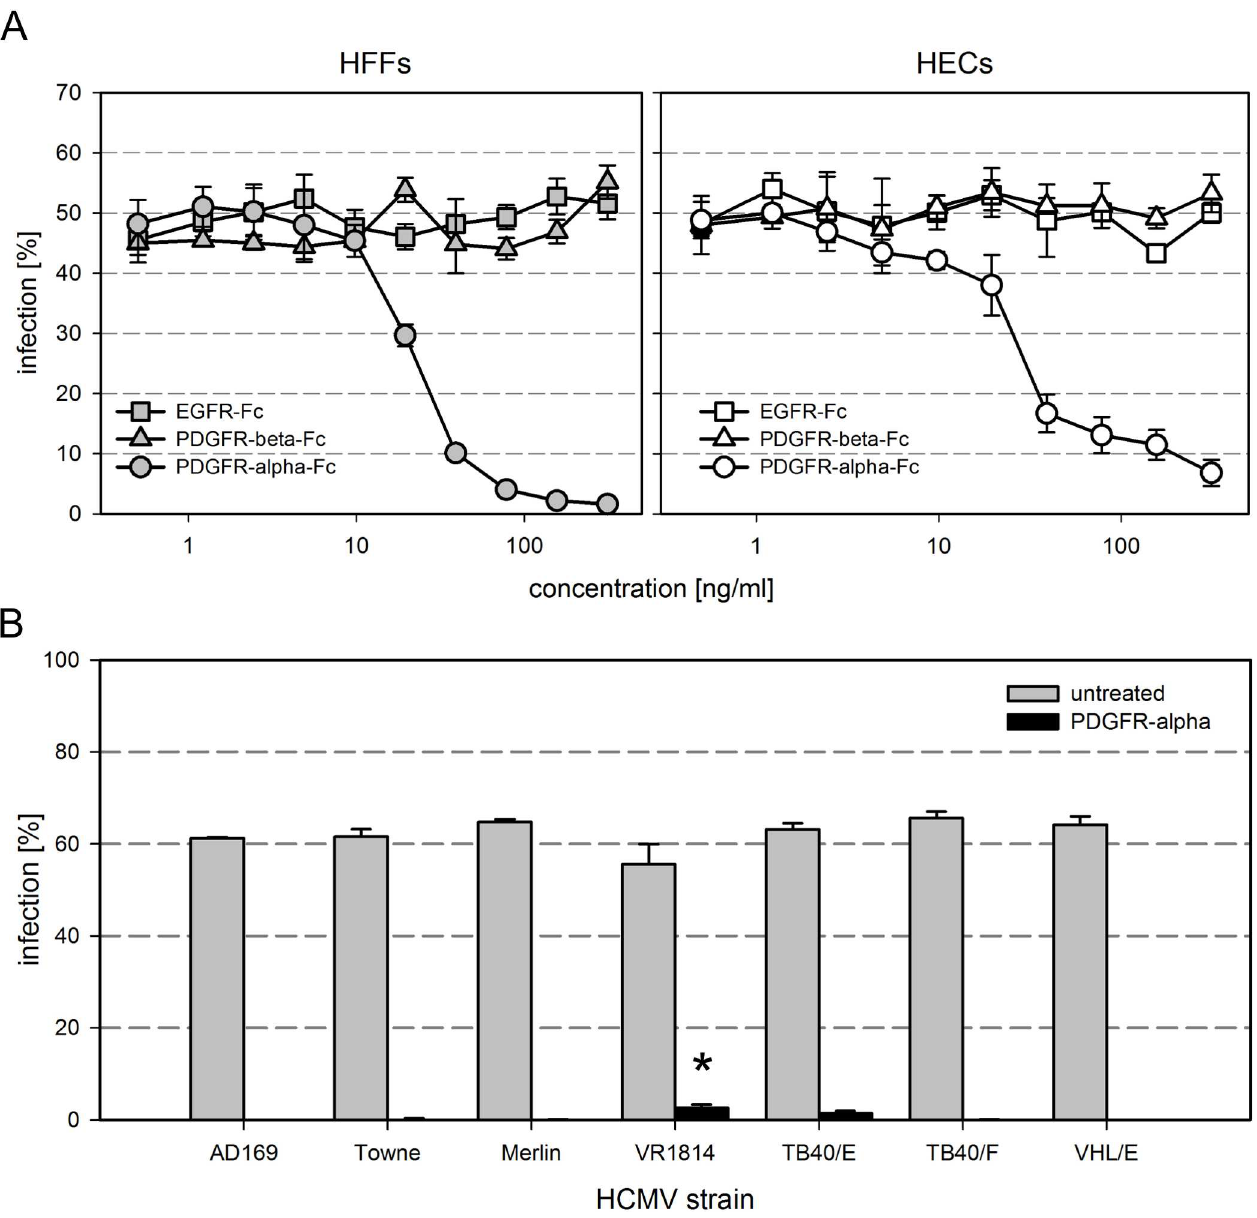
Fig 3. The inhibitory effect of soluble PDGFR-alpha is specific and affectsvarious HCMV strains. (A) PDGFR-alpha-Fc, PDGFR-beta-Fc and EGFR-Fc were comparedregardingtheir inhibitorypotential on infectionof fibroblasts (HFFs) and endothelial cells (HECs) by HCMV strain TB40/E. Virus preparations were pretreatedfor 2 h with the respectivegrowth factor receptorat indicatedconcentrations and then added to cell cultures for 2 h, followedby a medium exchangeand incubationovernight. Cells were fixed and stained for viral IE antigens. The percentageof infection was calculatedas the ratio of IE antigen-positive cells / total cell number. (B) The potential of PDGFR-alpha-Fc to inhibit fibroblast infection with variousHCMV strains was tested using a collectionof strains representingthe known glycoprotein variants. The virus preparations were either preincubated with medium (no drug) or medium containing250 ng/ml PDGFR-alpha-Fc. Error bars in (A) and (B) represent the standard error of the mean (SEM). The significantdifference of VR1814 as comparedto the other strains is indicatedby an asterisk.